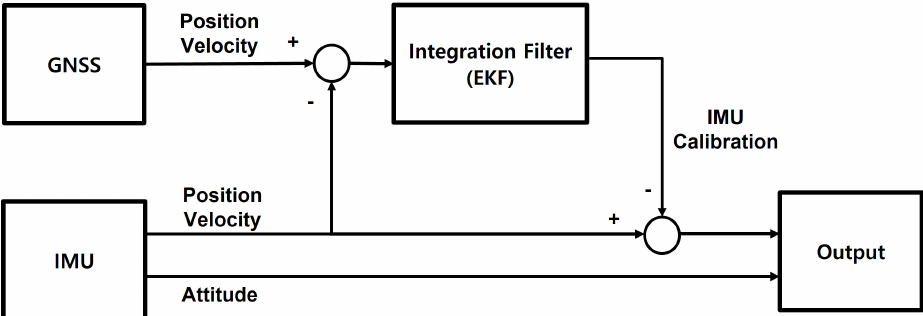
Figure 2. The block diagram of the GNSS/IMU loosely-coupled integration